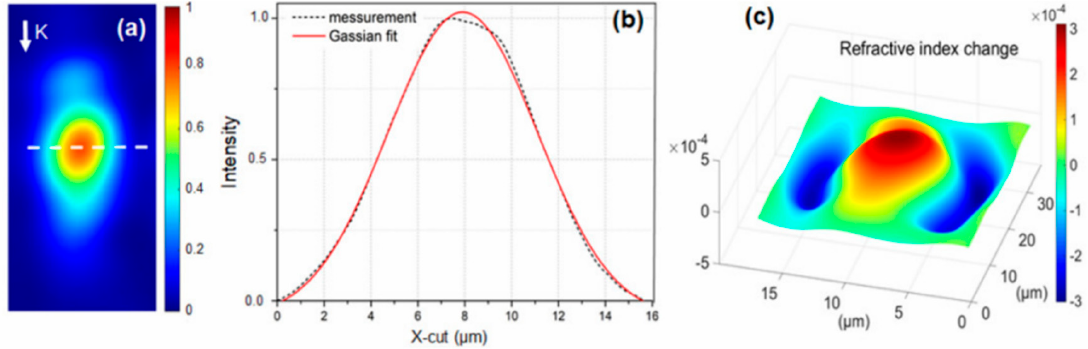
Figure 4. BWGs optical investigation results: near-field intensity distribution captured by CMOS camera (Gentec Beamage-3.0, QC, Canada) applying the objective (40 × , 0.65 NA) at the BWG output ( a ). K represents the wave vector direction. The dashed line represents the X-cut position; X -axis intensity distribution of the BWG mode ( b ); the simulated refractive index contrast of the BWG cross-section ( c